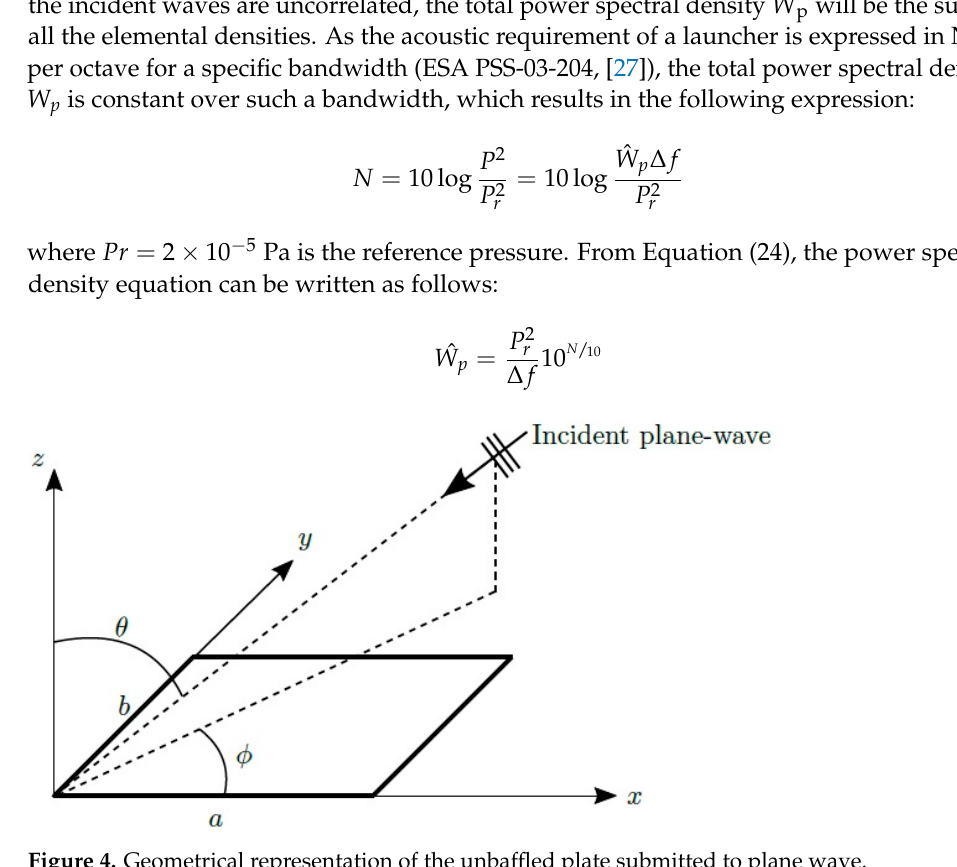
Figure 4. Geometrical representation of the unbaffled plate submitted to plane wave.